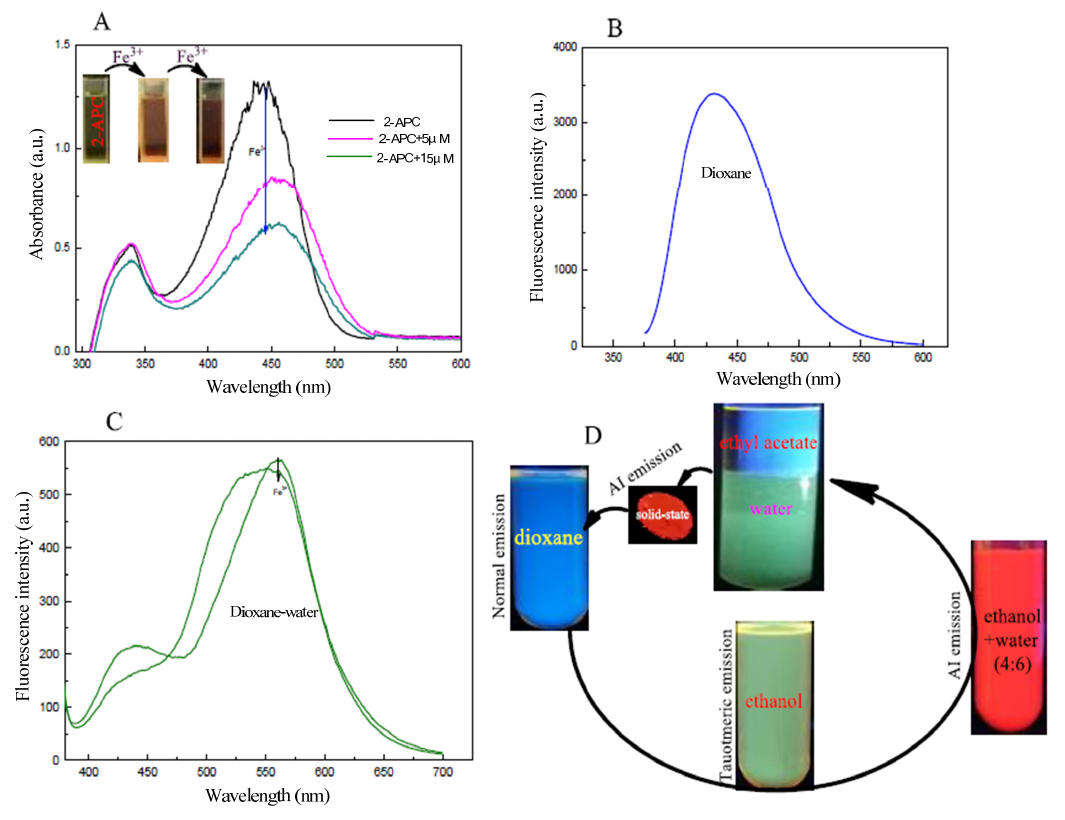
Figure 1. ( A ) UV-visible spectra of 2-APC in ethanol–HEPES buffer (10 mM, pH 6.5) system (ethanol: HEPES = 7:3, v/v ) and the same 2-APC solution with the additions of different concentration Fe 3+ ; ( B ) Fluorescence spectrum of 2-APC in dixoane; ( C ) Fluorescence spectra of 2-APC and 2-APC+Fe 3+ in dixoane-water system; ( D ) Fluorescence profiles of 2-APC in aprotic solvents, protic solvents and solid-state. The photographs were taken under 365 nm UV lamp. The concentrations of 2-APC were 2.5 μ M/L.